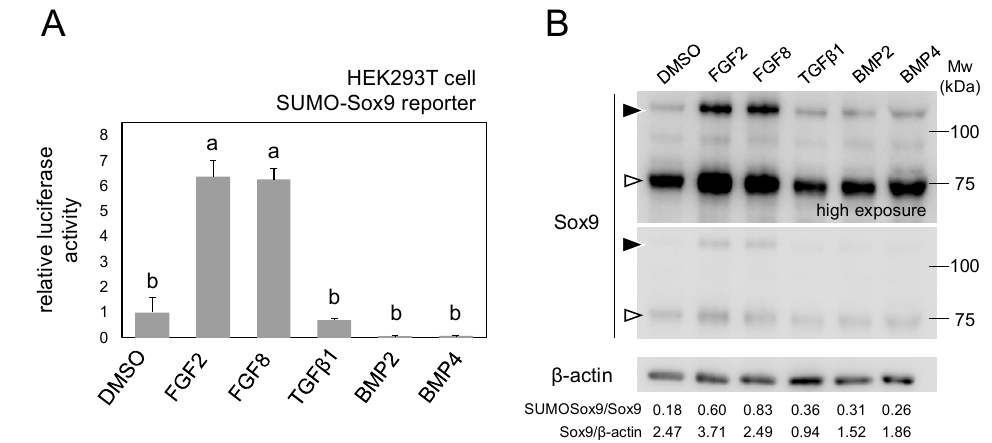
Figure 4. FGF signaling increases SUMOylated Sox9. ( A ) A luciferase assay for detecting the effects of cytokine treatments on Sox9 SUMOylation. HEK293T cells were transfected with SUMO-Sox9 reporter and treated with cytokines for 18 h, and the luciferase activity was then measured. Bars indicate the mean value of triplicate wells. Error bars indicate the standard deviation. The mean values sharing a letter did not differ to a statistically significant extent ( p ≥ 0.05, Tukey’s HSD test). ( B ) Western blotting of the cell extract prepared as those in ( A ). Sox9 blots with shorter exposure (middle panel) and longer exposure (upper panel) are shown. β -actin served as a loading control. White arrowhead indicates Sox9, and black arrowhead indicates SUMOylated Sox9. The ratios of SUMOylated/non-SUMOylated Sox9 and non-SUMOylated Sox9/ ß -actin are shown at the bottom. All experiments were repeated at least twice, and representative results are shown.